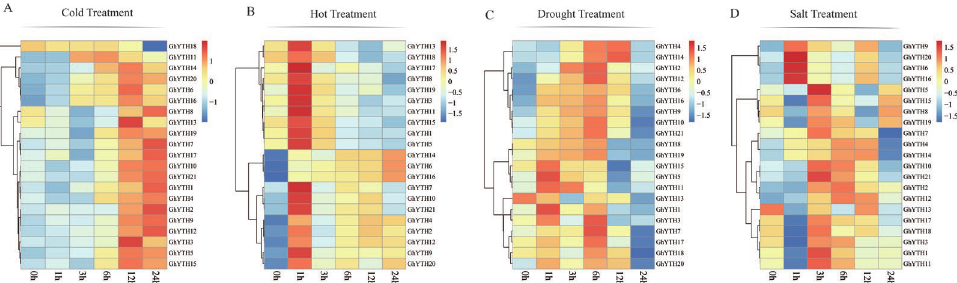
Figure 9. Expression patterns of GhYTH genes under different abiotic stresses. ( A ) Expression patterns of GhYTHs under cold stress (0, 1, 3, 6, 12, and 24 h). ( B ) Expression patterns of GhYTHs under hot stress (0, 1, 3, 6, 12, and 24 h). ( C ) Expression patterns of GhYTHs under drought stress (0, 1, 3, 6, 12, and 24 h). ( D ) Expression patterns of GhYTHs under salt stress (0, 1, 3, 6, 12, and 24 h).